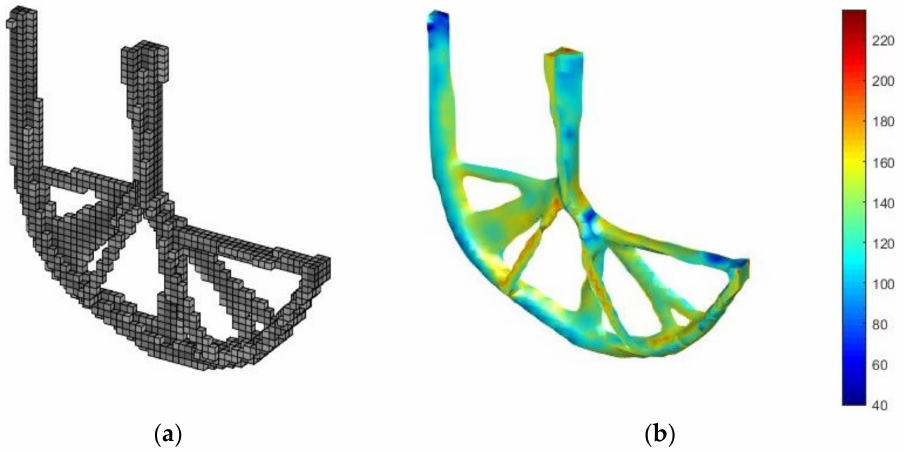
Figure 19. Deterministic topology optimization results for 3D L-shaped beam: ( a ) Topological structure; ( b ) Von Mises stress distribution.